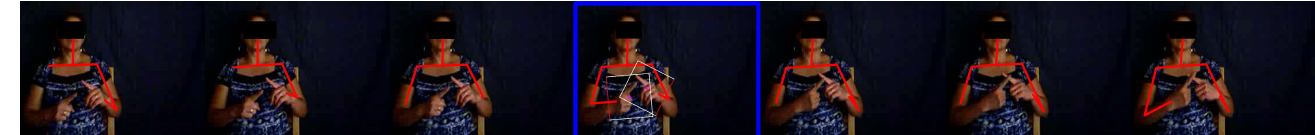
Figure 2. The Skeleton Filter described in Section 5.1.1. Images are arranged from left to right in chronological order. The central image shows the skeleton output by the filter. The six other images show the raw skeletons output by OpenPose . Observe that—thanks to Equation (1)—our filter has added the right wrist coordinates (shown only in the central image). These are obtained from the K -th frame, while they were missing in all raw skeletons from frame 1 to K − 1.